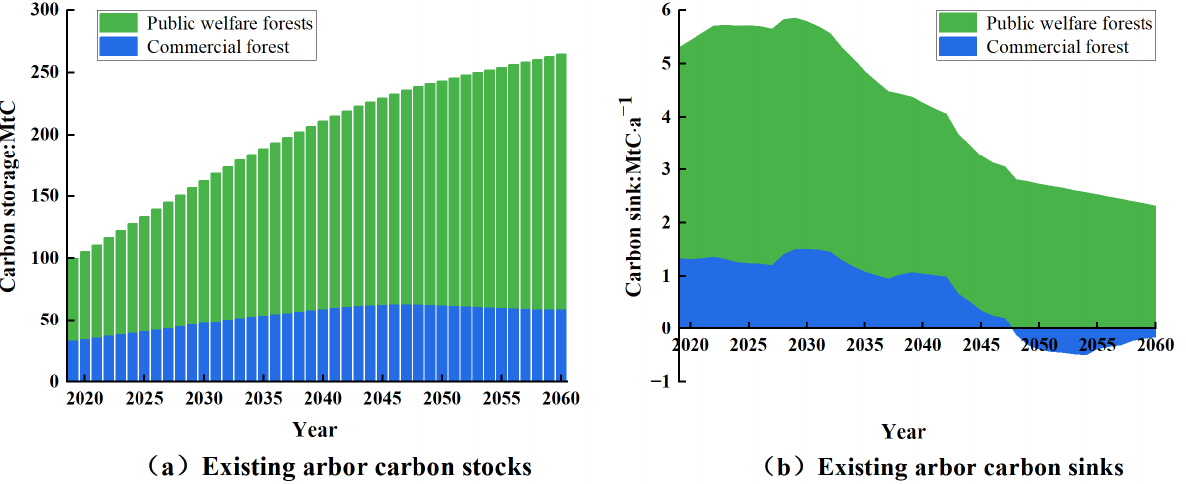
Figure 2. Carbon-sink capacity of existing arbor forest vegetation in Henan Province, 2019–2060.